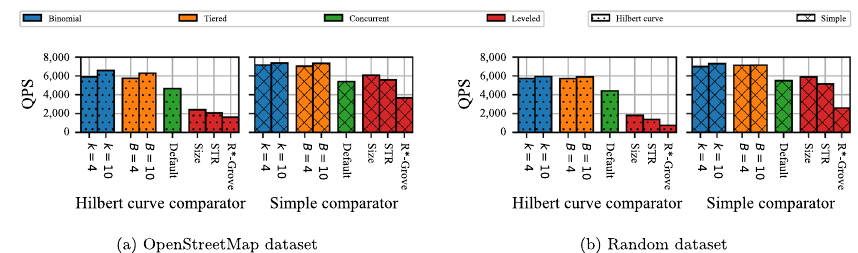
Fig. 10 Average write throughput (requests per second) for all policies with different